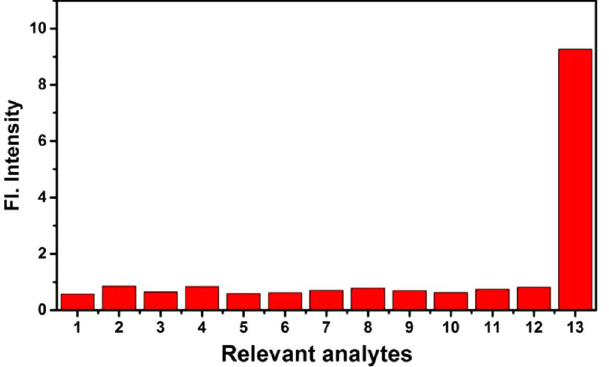
Figure 6. The fluorescence intensity of probe NS-N 2 H 4 (10 μ M) in the presence of various analytes ( 1 0 equiv) in PBS buffer (pH 7.4 PBS/DMSO (v/v = 2/1)). 1: none; 2: Al 3 + ; 3: Ca 2 + ; 4: Co 2 + ; 5: Cu + ; 6: Cu 2 + ; 7: Mg 2 + ; 8: Zn 2 + ; 9: S 2 − ; 10: SO 32 − ; 11: Cys; 12: Cl − ; 13: N 2 H 4 .